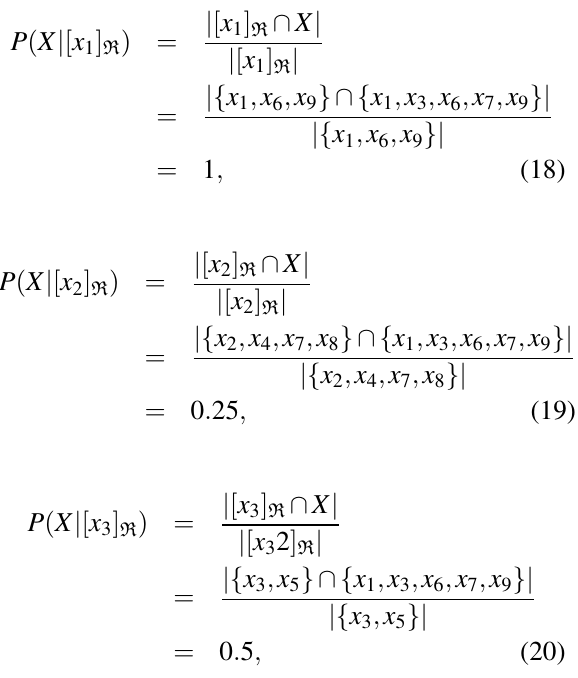
Table 2. A payoff matrix of three-way view decision